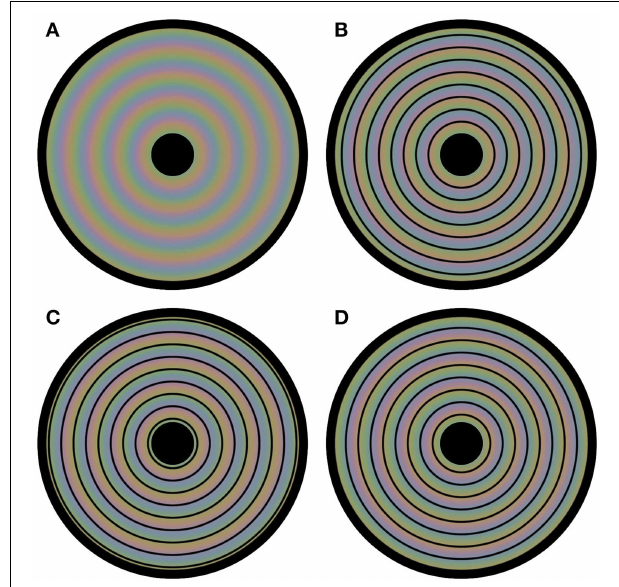
FIGURE 1 | Flexible colors. All four panels contain a disk that evokes four distinct colored experiences. However, each panel has the same underlying blurry colored image. The only physical difference between the panels is the positioning of circular outlines on top of this colored image. In (A) no outlines are presented, leading to a continuous perceptual color change from the center to the periphery of the disk. The positioning of the contours is at a different phase for each of (B–D) . Although the physical color changes are gradual and continuous in all panels, the color appearance seems rather homogeneous between each pair of neighboring outlines; the colors average between the outlines